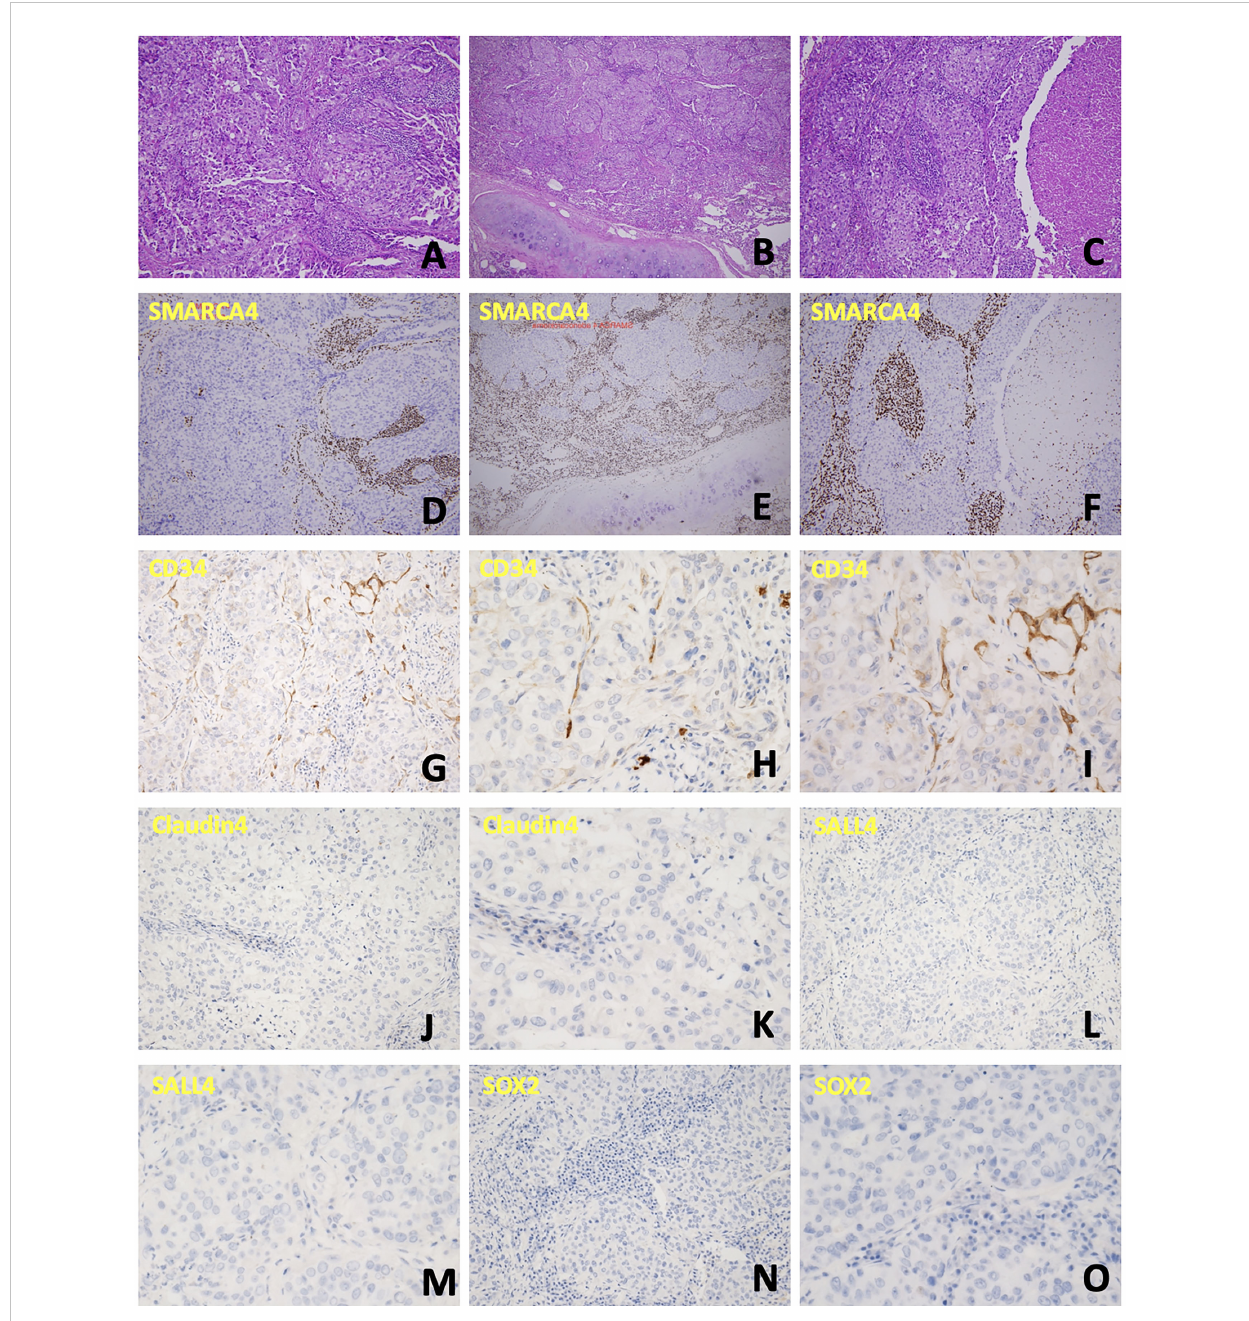
FIGURE 2 Cellular characterization of the disease course. (A) Neoplastic cells arranged in con fl uent papillary and glandular structures. (B) The tumor was arranged in in fi ltrative nests, with necrosis and focal extracellular and intracellular mucin production noted. (C) Tumor cells were arranged in solid nests and occasional papillary structure, with lymphovascular invasion also present. (D-F) Immunochemical staining to detect SMARCA4 corresponding to the above specimen; all these tumors cells were negative for SMARCA4 expression. (G-I) CD34 is weakly positive. (J, K) Claudin4 is negative. (L, M) SALL4 is negative. (N, O) SOX2 is